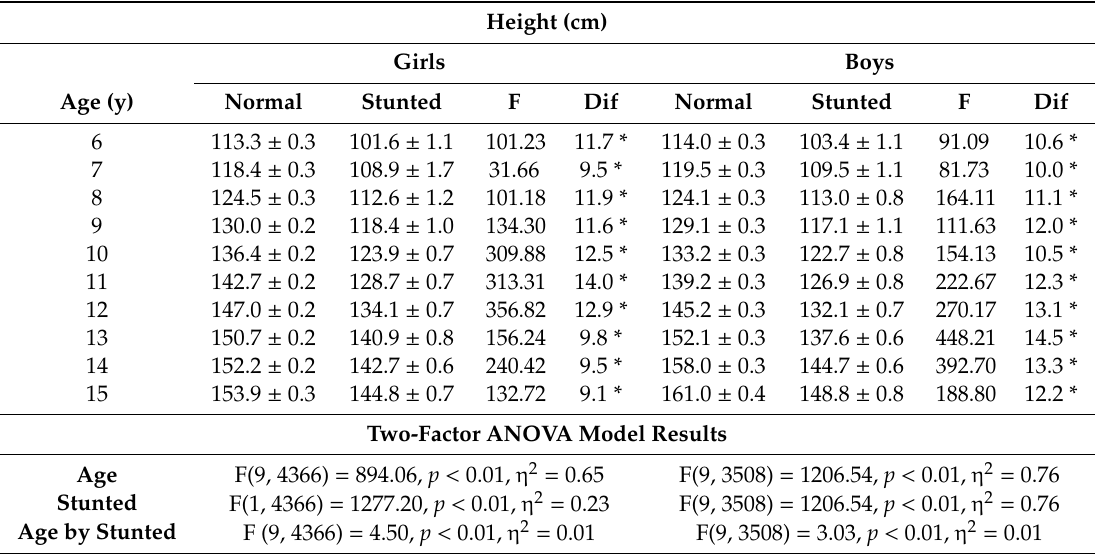
Table 2. Mean di ff erences (Mean ± SD, F tests and Dif) and two-factor analysis of variance (ANOVA) model results for height between stunted and normal-growth children of both sexes. Height